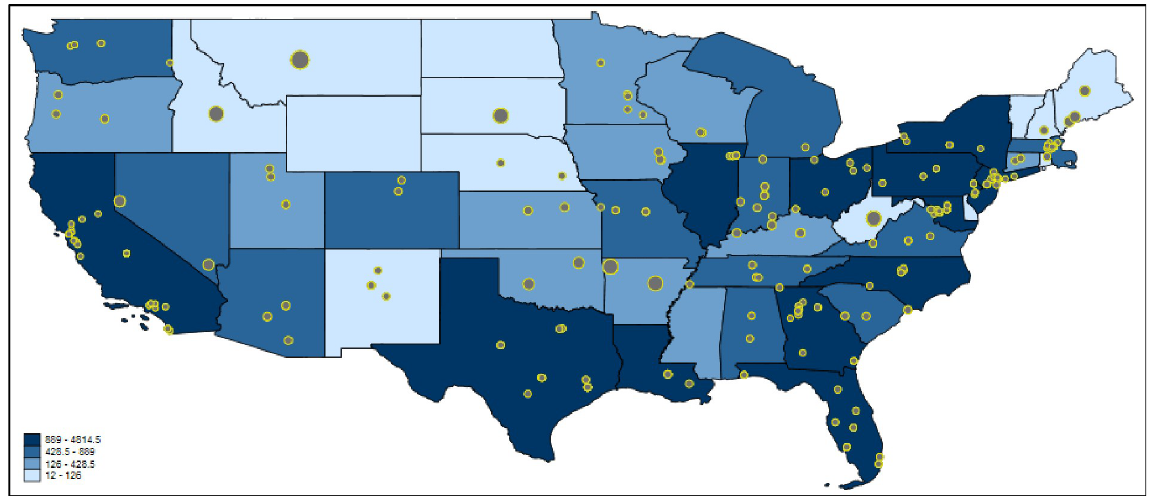
Fig 6. Tweeting on papers dealing with HIV in the USA. Each tweet is inversely weighted with the number of papers published by authors in the corresponding US state: the larger the dots, the smaller the research activity. The US states are colored according to the total number of HIV cases in 2016/2017